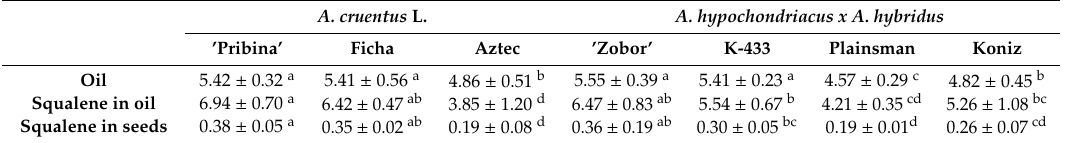
Table 3. Crude oil and squalene content (%) in amaranth seeds in three year period (2016–2018). A. cruentus